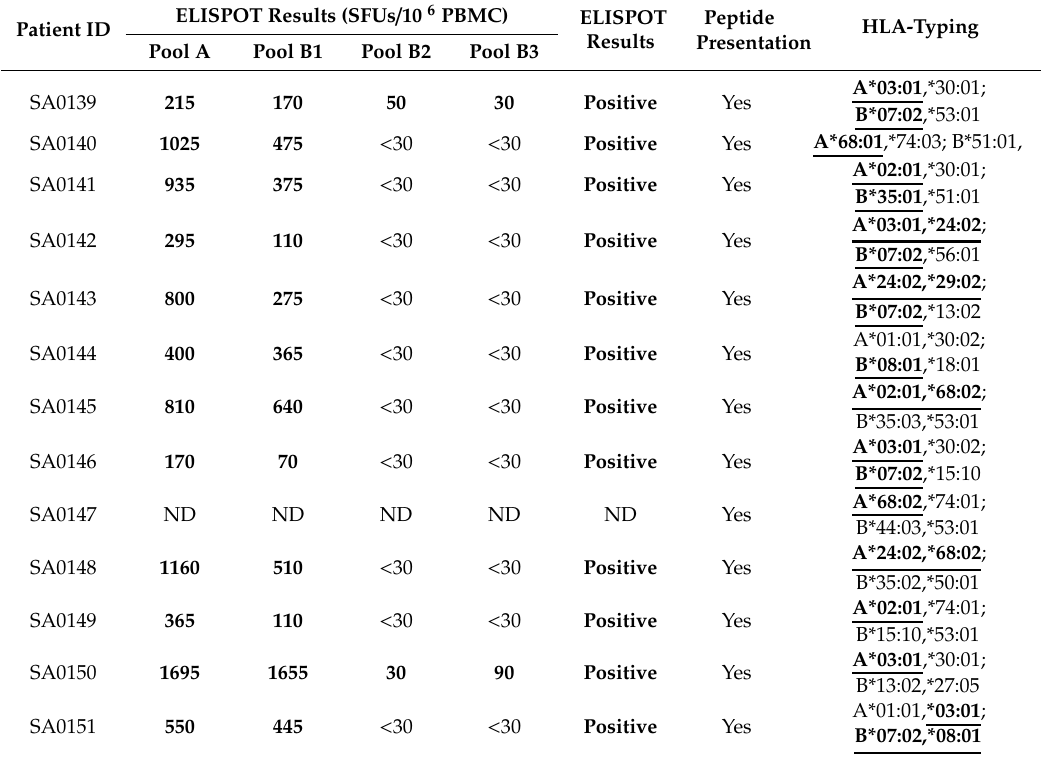
di ff erences in these percentages between reactive and nonreactive patients (CD4 + T cells: t = 0.65624, df = 7.2029, p -value = 0.5321 Welch Two Sample t -test; CD8 + T cells: t = 019264, df = 5.0683,